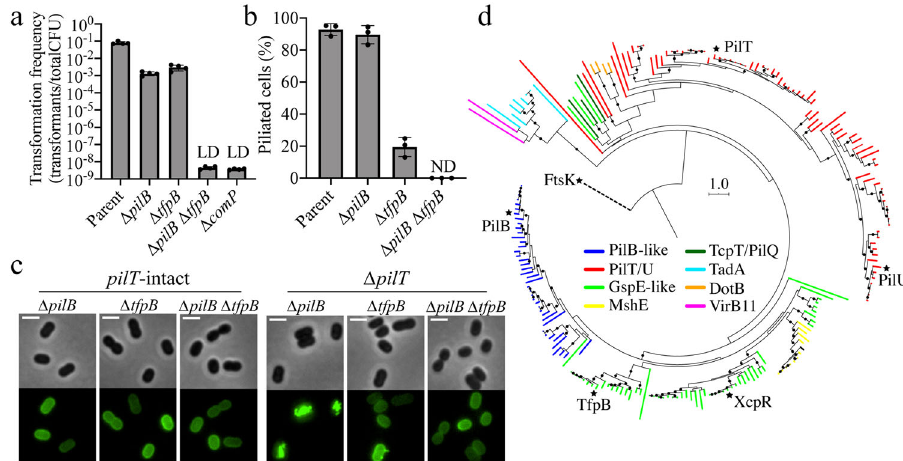
Fig. 2 TfpB is a phylogenetically distinct PilB homolog that is required for ef fi cient T4P extension in A. baylyi . a Natural transformation assays of indicated strains. Each data point represents a biological replicate ( n = 4) and bar graphs indicate the mean ± SD. LD limit of detection. ComP is the major pilin in A. baylyi , and the mutant is used here as a negative control. b Percent of piliated cells in pilT mutant populations of indicated strains. Each data point represents an independent, biological replicate ( n = 3) and bar graphs indicate the mean ± SD. For each biological replicate, a minimum of 70 total cells were assessed. ND no pili detected. c Representative images of indicated strains labeled with AF488-mal with background fl uorescence subtracted. Scale bars, 2 µ m. d A rooted phylogeny of TfpB homologues found among Gammaproteobacteria. Branches are colored according to protein annotations in IMG, and nodes with bootstrap values greater than or equal to 70% are indicated by black circles. Black stars are at the tips of branches representing A. baylyi proteins with indicated protein names. Source data are provided as a Source Data fi